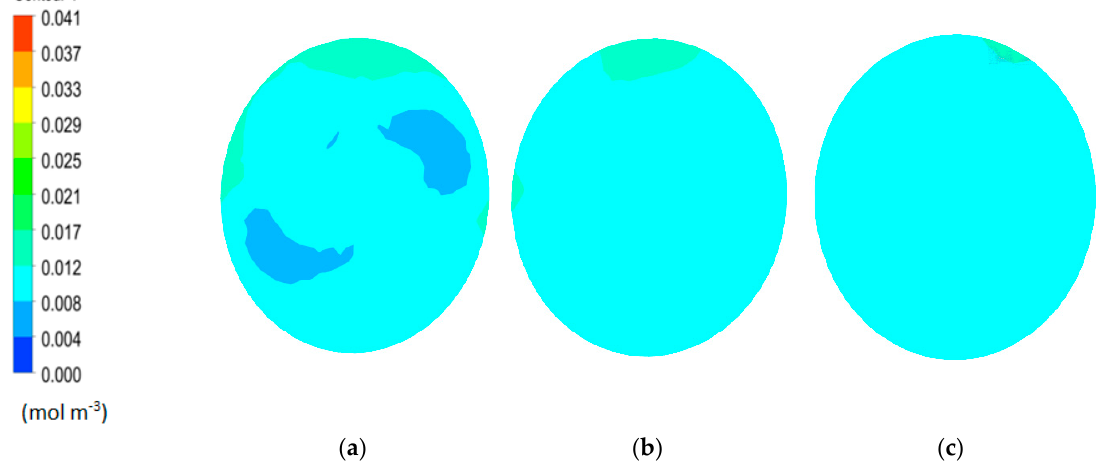
Figure 8. Velocity contour maps at the inlet of catalyst inlet.( a ) Line (LM) mixer,( b ) swirl (SM) mixer, and( c ) two mixers (LSM).